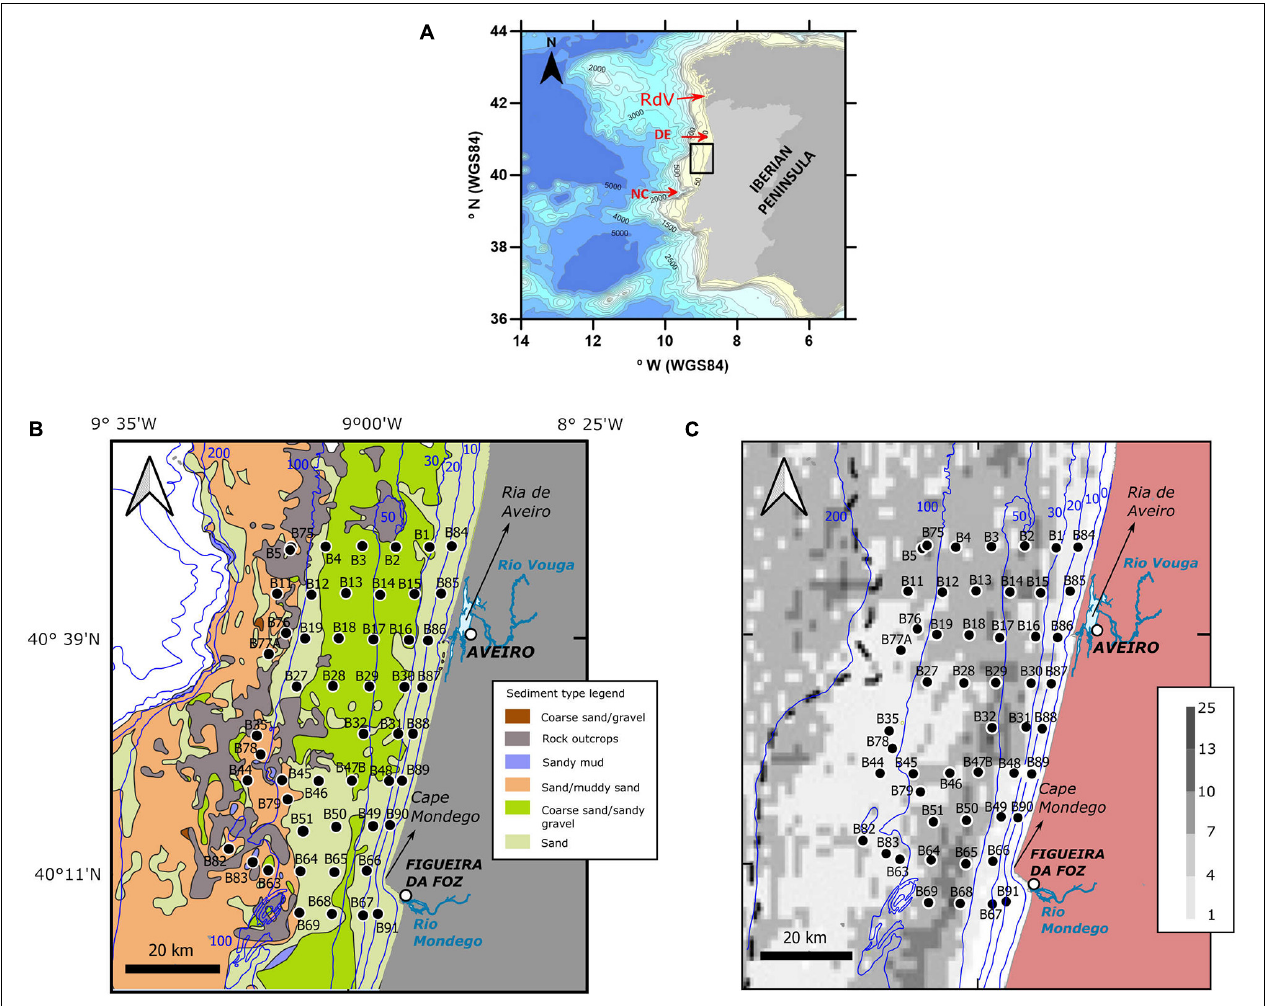
FIGURE 1 | Study site and location of sampling stations off Aveiro-Figueira da Foz (Atlantic Iberian margin). Red arrows (A) indicate the position of the Douro estuary (DE) and the Nazaré canyon (NC). Station positions (B,C) are superimposed on the Seabed Substrate maps from EMODnet Geology (https://www.emodnet-geology.eu/map-viewer/?p=seabed_substrate) (B) and the frontal probability map performed by Relvas et al. (2007) from average SST anomalies ( ◦ C) of satellite-derived summer data for the period 2001–2005 (C) . Bathymetric contours are in meters and are taken from the General Bathymetric Chart of the Oceans (https://www.gebco.net/) (A) and the IH (https://www.hidrografico.pt/op/33) (B,C)